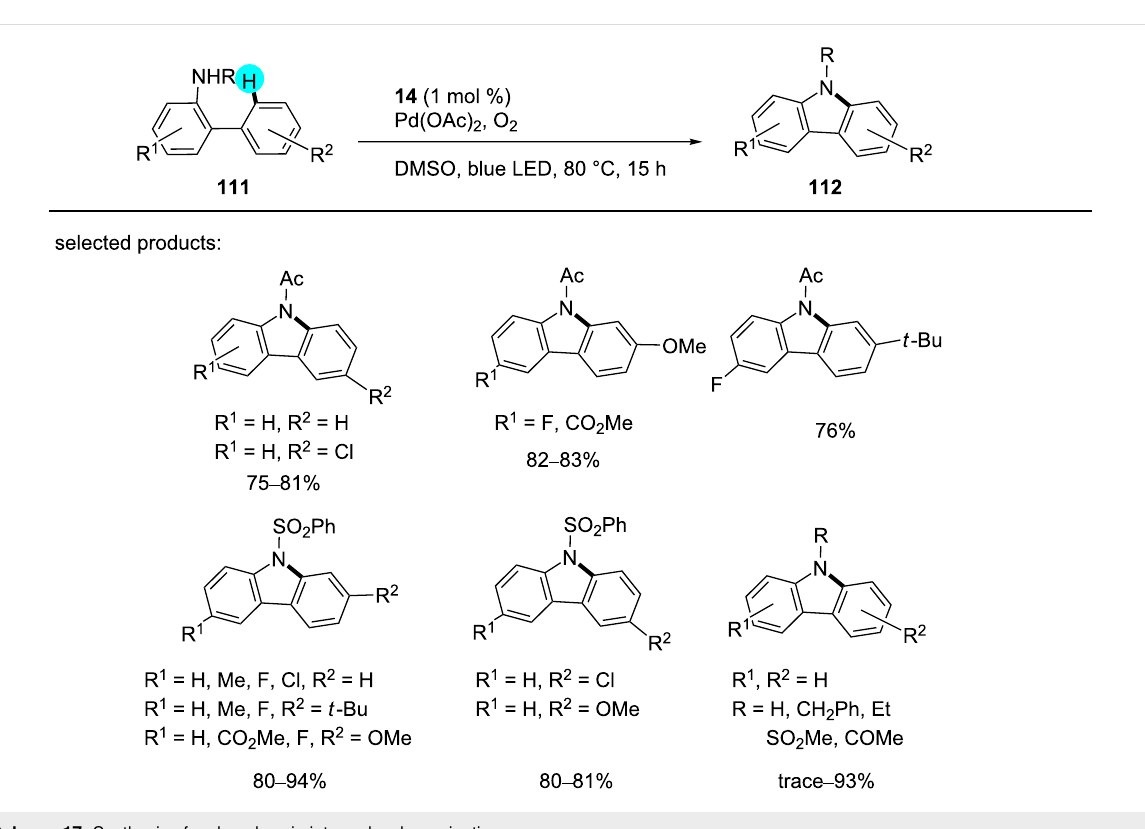
Scheme 17: Synthesis of carbazoles via intramolecular